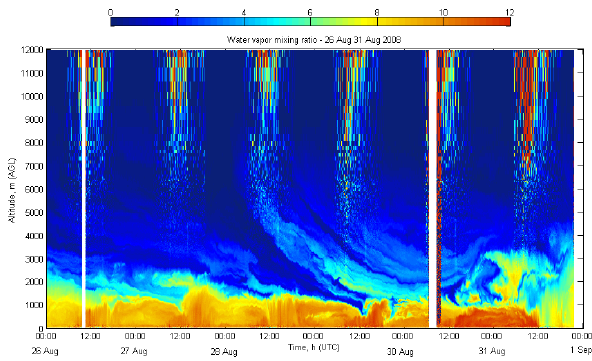
Fig. 14. Six-day time series of water vapor with 10 min time res- olution. All data are shown, including data with a statistical error > 10%. The noisy zones above 5000 m (around noon) mark the increase in statistical error due to the solar background during the daytime. The white zones mark data